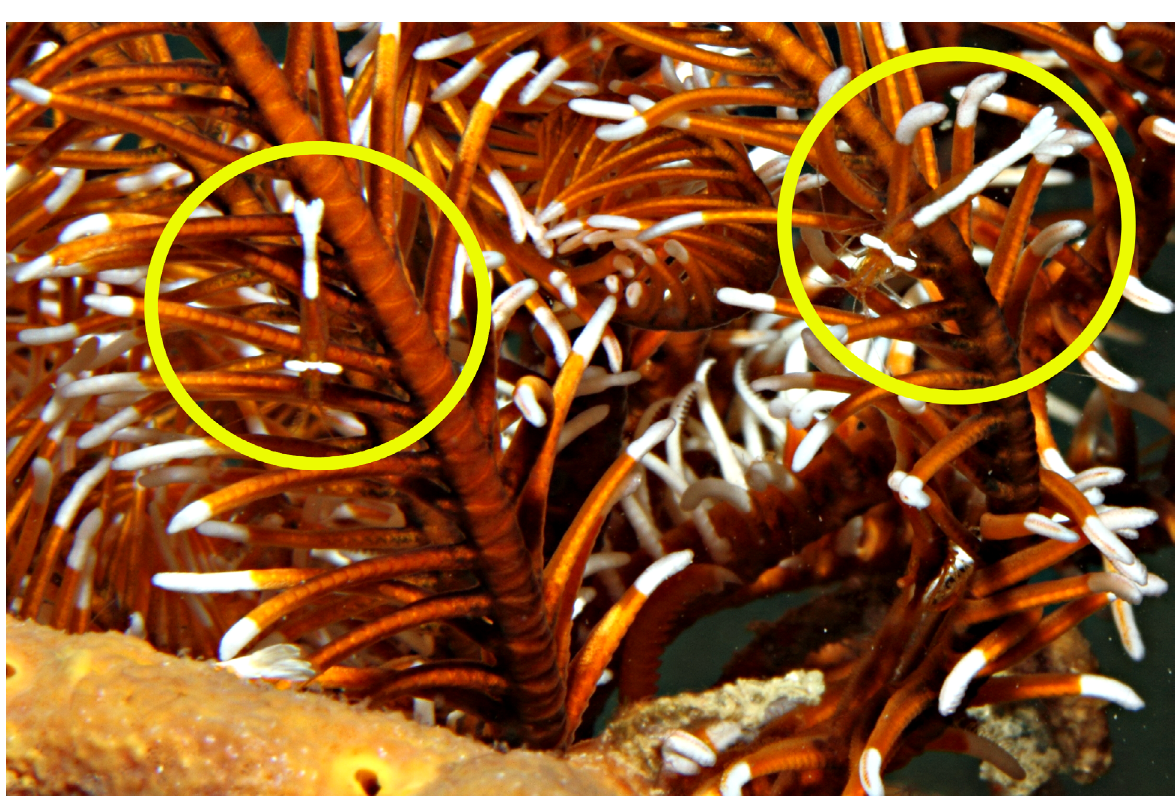
Figure 2. Mimicry of the shrimp Periclimenes crinoidalis associated with the crinoid Nemaster cf. grandis , in Chichiriviche de la Costa, Vargas State,